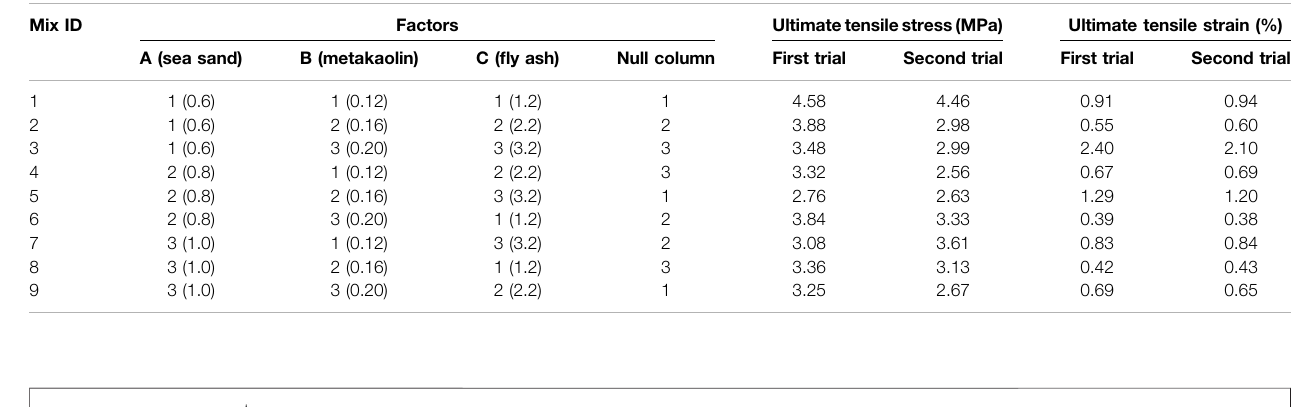
TABLE 5 | Results of the uniaxial tensile test of SECCs.